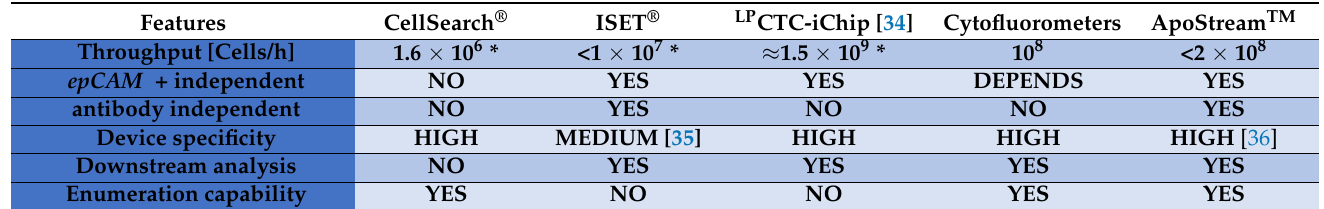
Figure 5. Schematic, side-view, of the ApoStream TM device, showing the complex multi-inlet, multi- outlet, and microfluidic system. (Adapted from [30]). Table 1. Details of extracted device characteristics can be found in ref [32,33]. * Throughputs have been extrapolated based on processing time.